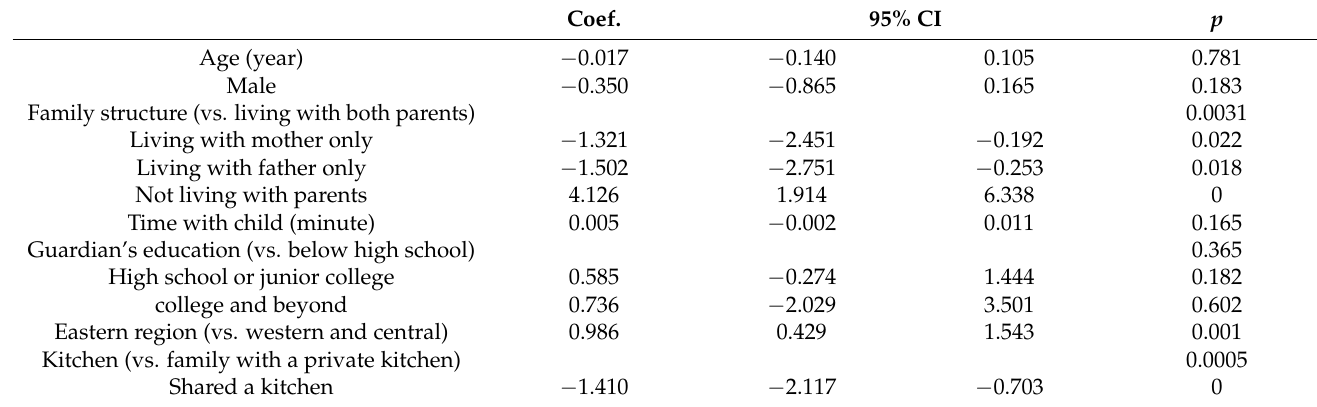
Table A3. Univariate OLS Analyses for Migrant Children’s Self-Esteem